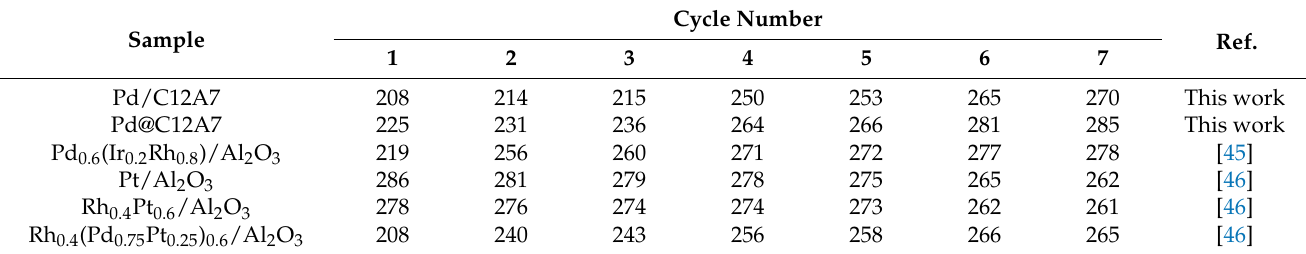
Table 4. Comparison of the catalytic performance data (T 50 ) for the studied samples and recently reported